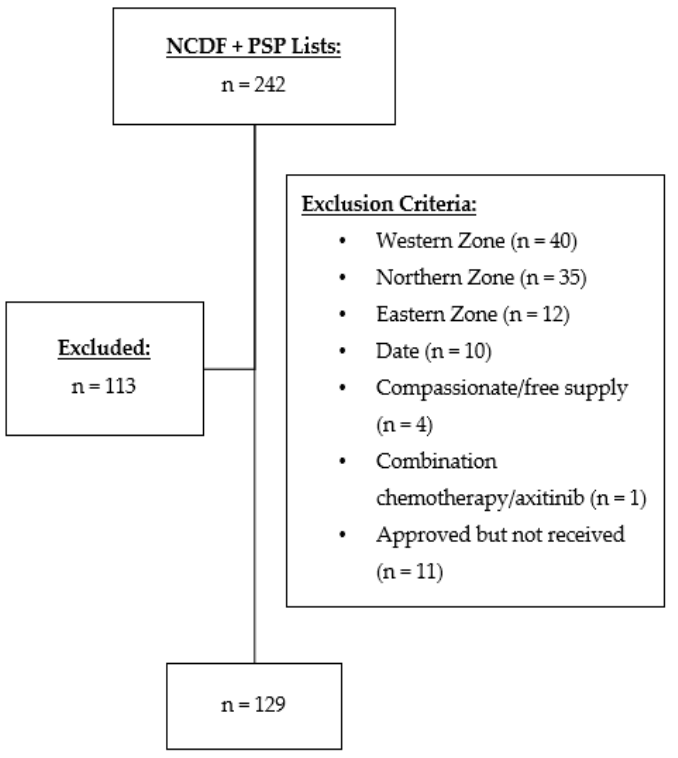
Figure 1. Participant selection flow diagram of medical oncology patients receiving nivolumab, ipilimumab, or nivolumab plus ipilimumab at Nova Scotia Health-Central Zone between 2010–2020. NCDF: New Cancer Drug Fund; PSP: Patient Support Program. Table 1. Baseline characteristics of Nova Scotia Health-Central Zone medical oncology patients re- ceiving nivolumab, ipilimumab, or nivolumab plus ipilimumab from 2013–2020 ( n = 129).